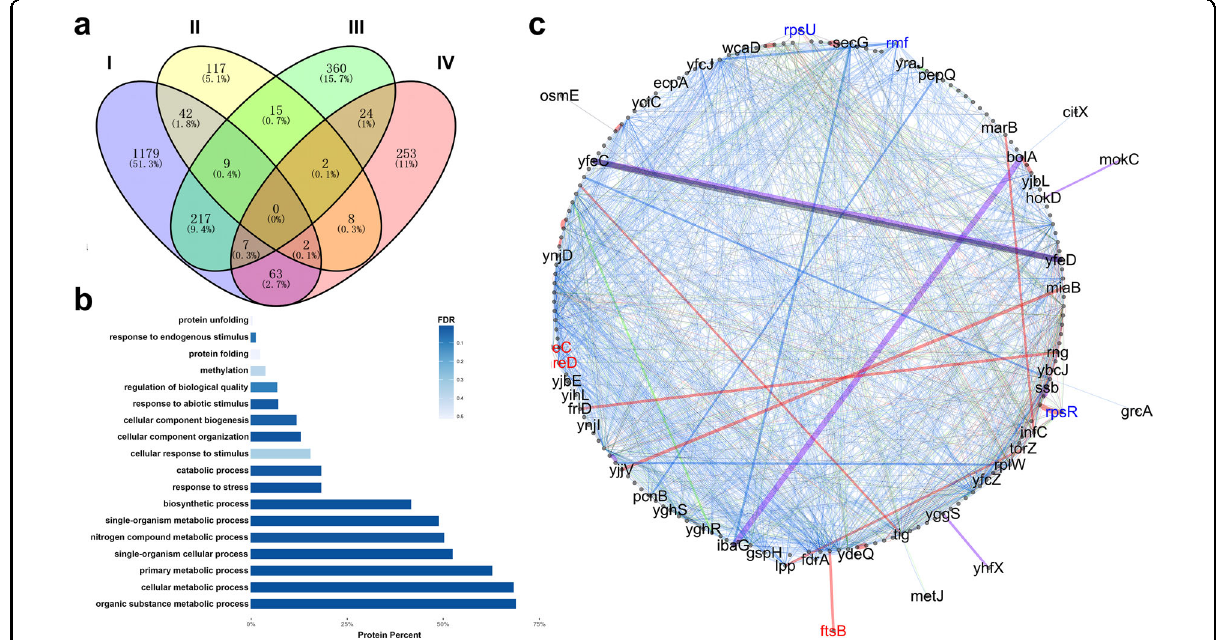
Fig. 4 The integration function of CspL in vivo. a Venn diagram showing transcriptionally upregulated genes (I), mRNA binding targets of CspL at 37 °C (II) and 45 °C (III), and proteomic level differences (IV). b GO Mapper analysis performed on the label-free proteome datasets to reveal the global regulation at 45 °C in cspL -expressing cells. c The regulation network of binding targets. The gene names in red ( mreC , mreD , and ftsB ) were directly related to cell wall synthetic processing, gene names in blue ( rpsR , rpsU , and rmf ) were responsible for ribosome synthetic processing. Branch color indicates the type of interaction. Blue, genetic interactions; purple, shared protein domain; pink, physical interactions; green, co-expression; and gray,